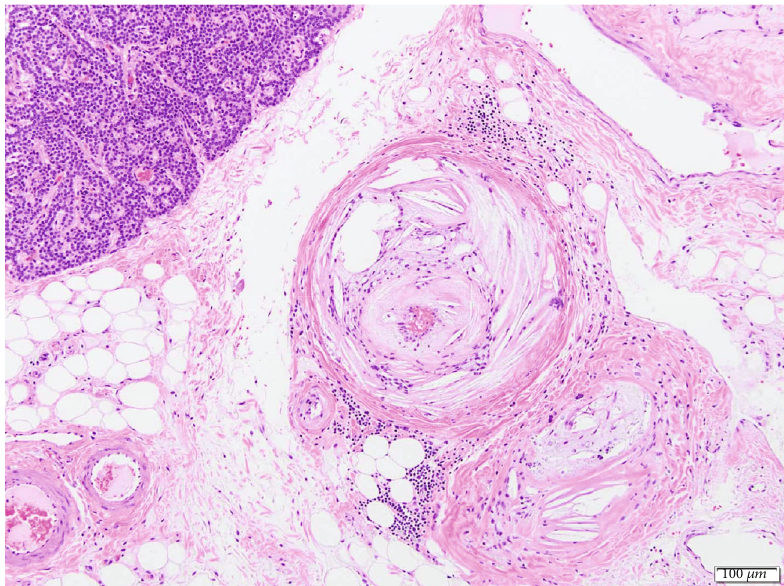
Figure 5: Histopathology of the right thyroid gland (hematoxylin and eosin stain, 10x). Histologically normal parathyroid tissue is seen in the top left. No thyroid follicular epithelium is noted (severe atrophy/loss). The tunica media of this artery is markedly expanded by foam cells, cholesterol clefts, and eosinophilic proteinaceous debris. The tunica adventitia is expanded by fi brous connective tissue, and there is mild lymphoplasmacytic in fi ltration within the vessel wall and extending into the adjacent fi brofatty